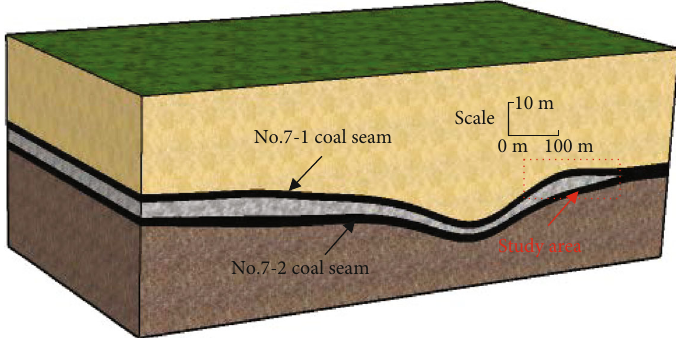
Figure 1: Schematic diagram of the no. 7-1 and no. 7-2 coal seams.